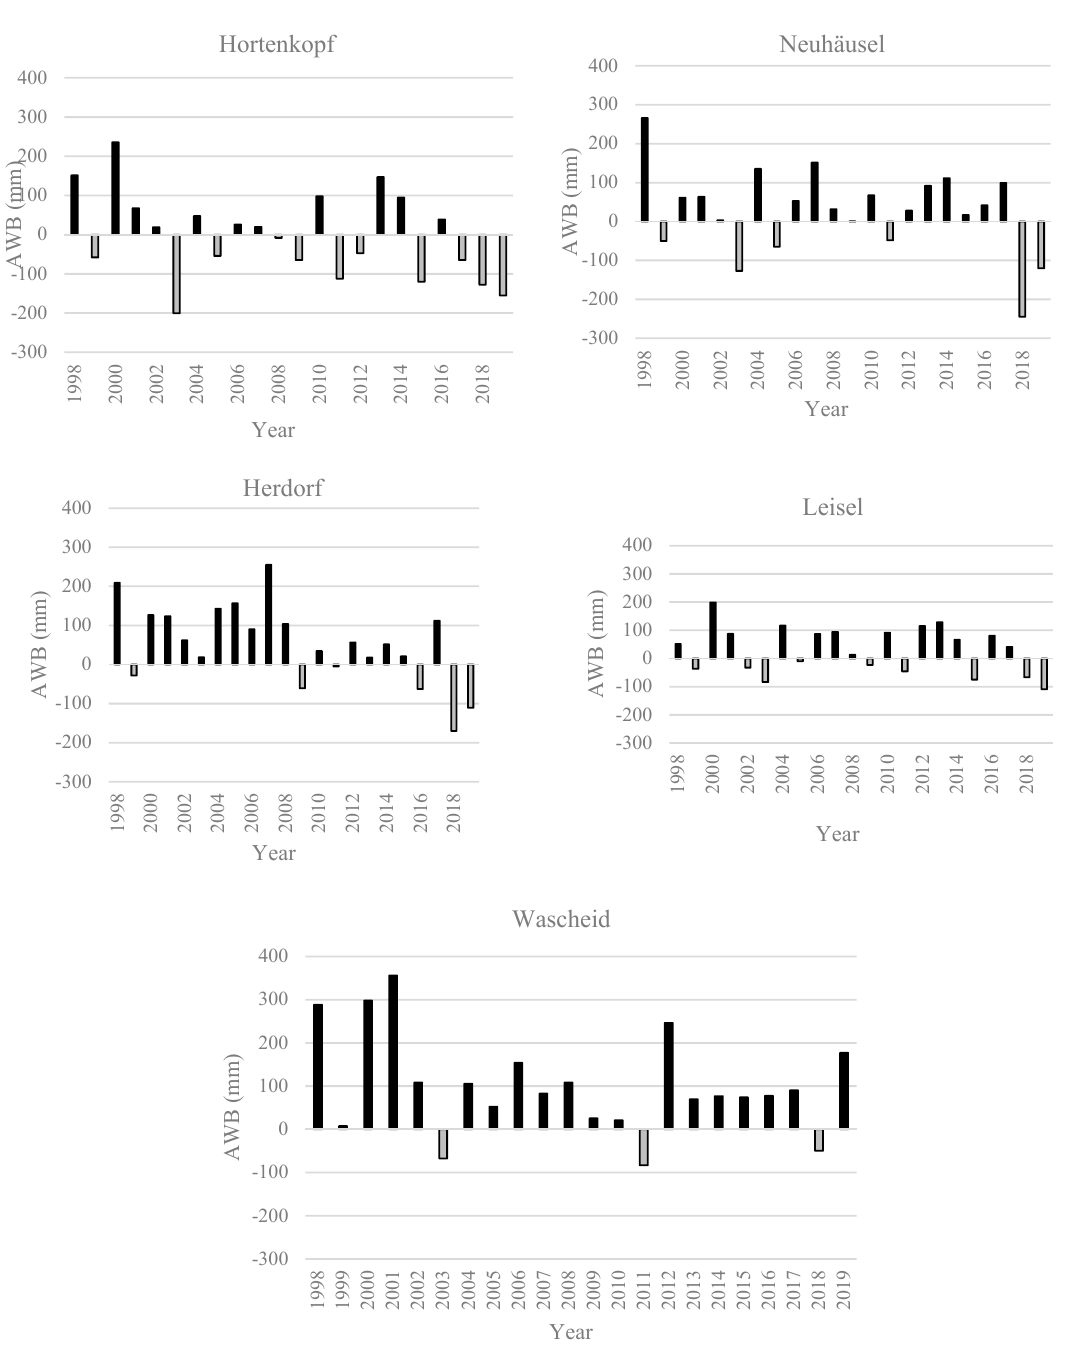
Figure 6. Atmospheric water balances (AWB, mm) of the investigated sites during the growing season (1 April to 30 September) for the years 1998 to 2019. This figure shows positive (black columns) and negative AWB (grey columns), representing humid and arid conditions, respectively.